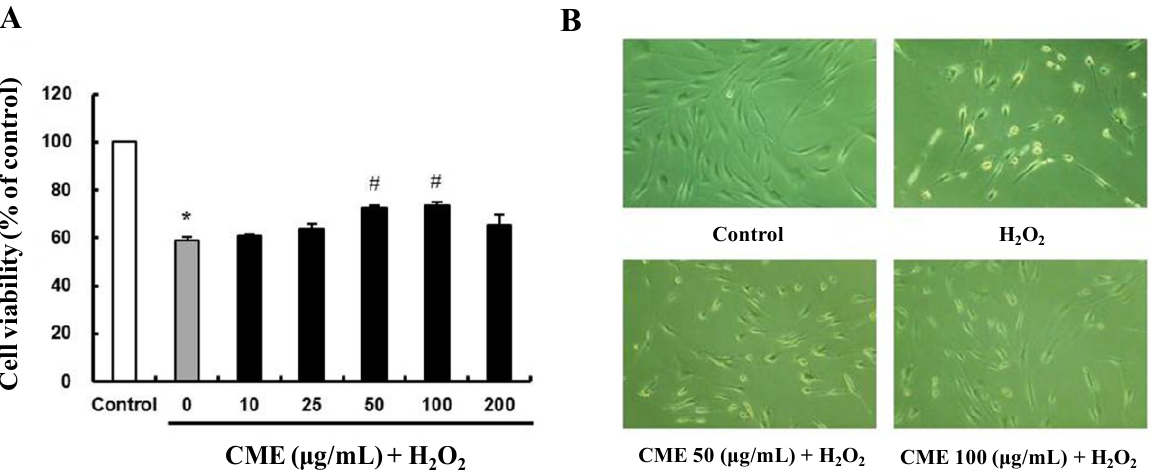
Figure 3. Protective effect of CME on H 2 O 2 -treated HDFs. ( A ) Cells were exposed to 10–200 μg/mL of CME for 4 h, then 0.8 mM H 2 O 2 for 3 h. Cell viability was determined using the MTT assay. Data represent the mean ± SE of three independent